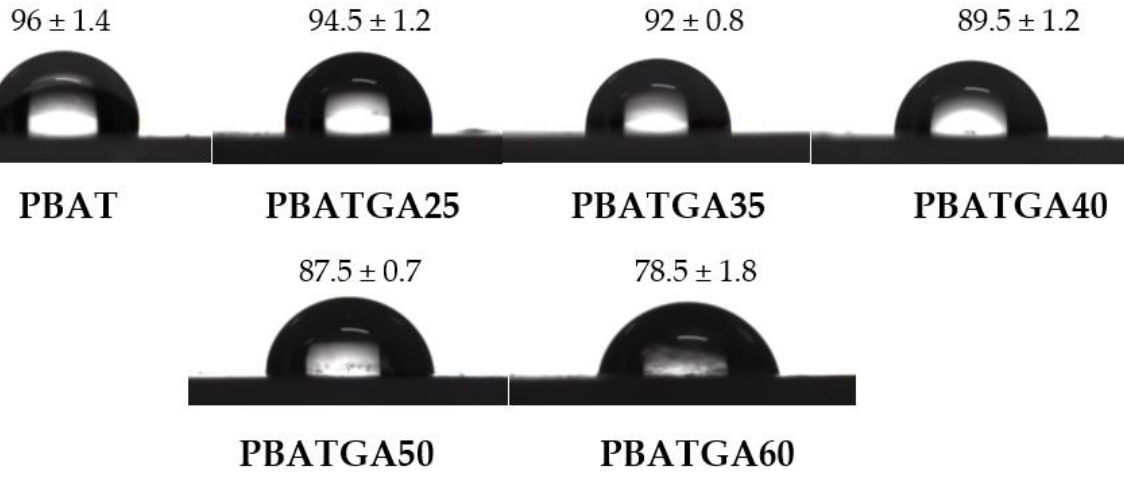
Figure 6. Water contact angle of the PBATGAs.